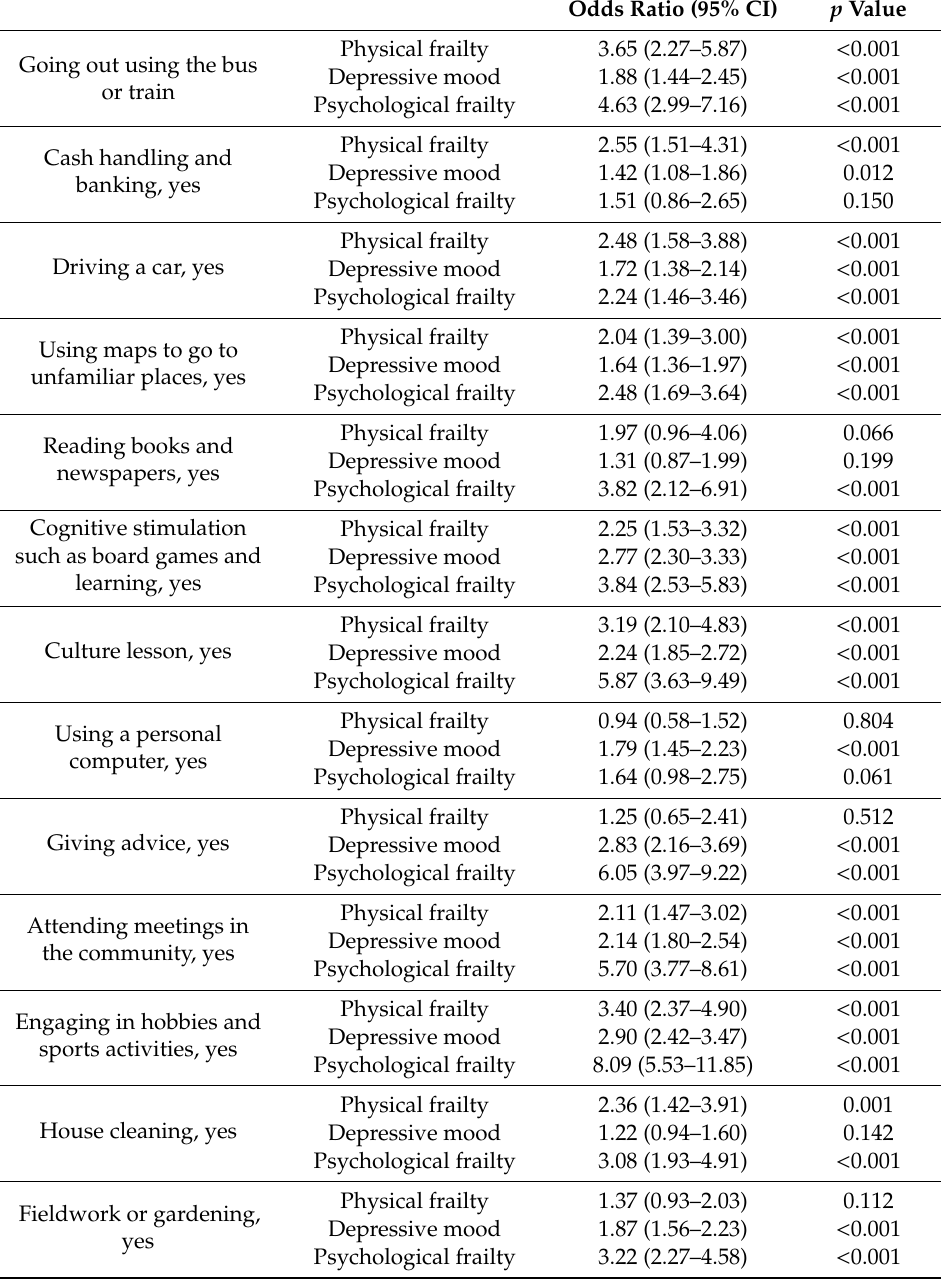
Table 2. Relationships between frailty status and lifestyle activity. Odds Ratio (95%